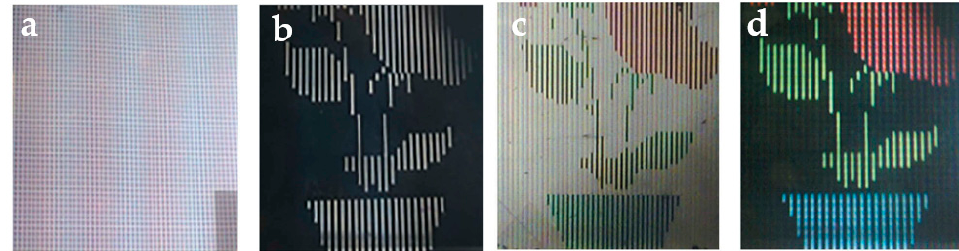
Figure 8. Flower images of color optically driven LCDs: ( a ) gridded color map; ( b ) flower pattern without color filter; ( c , d ) transmissive and reflective modes with color filter, respectively (each colored line width ≈ 1 mm) [45].